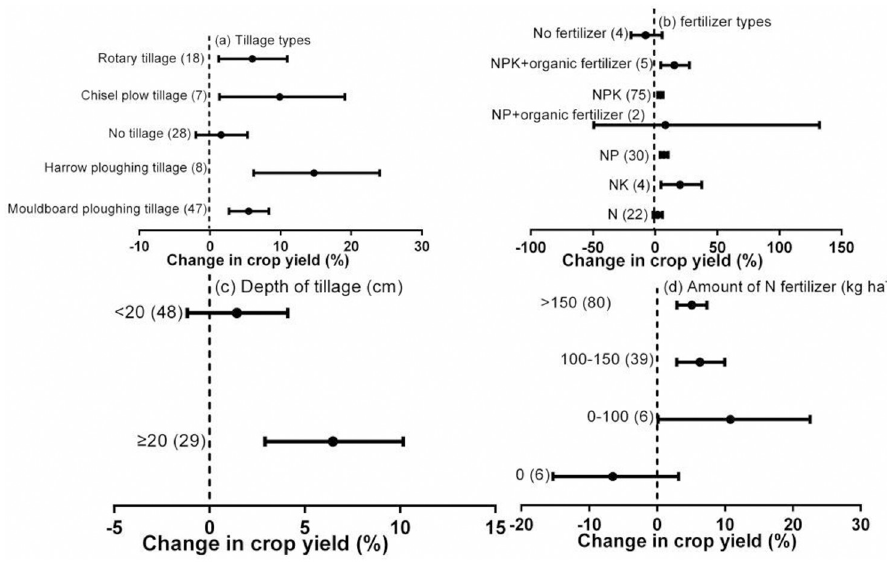
Fig 4. Effect of crop residue return on crop yield under different tillage types (a), depth of tillage (b), fertilizer types (c), and amount of N fertilizer (d). Error bars represent the mean value ± 95% CI.